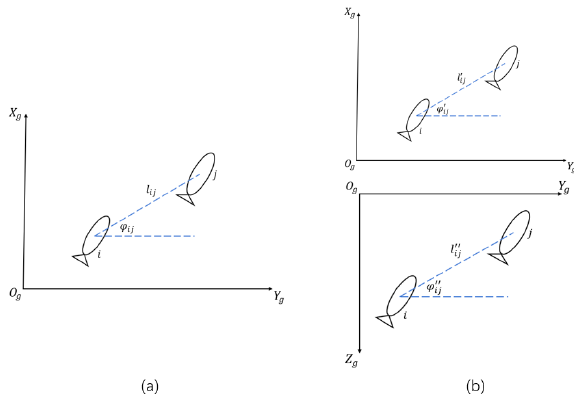
Fig. 4 Relative positional relationships among AUVs in (a) 2D and (b) 3D